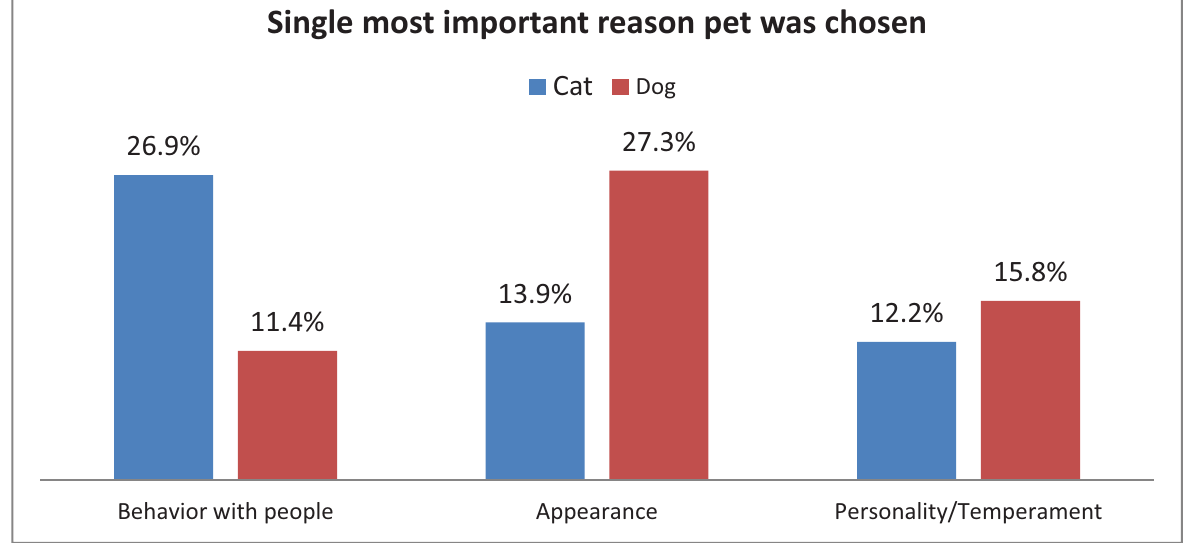
Figure 3. Adopter’s responses when asked the most important reason they choose their kitten or adult